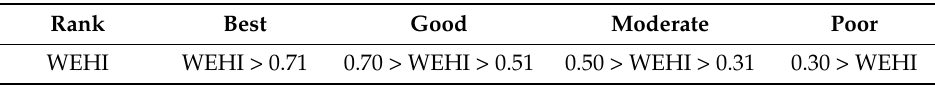
Table 3. Wetland ecological health index (WEHI) reclassified